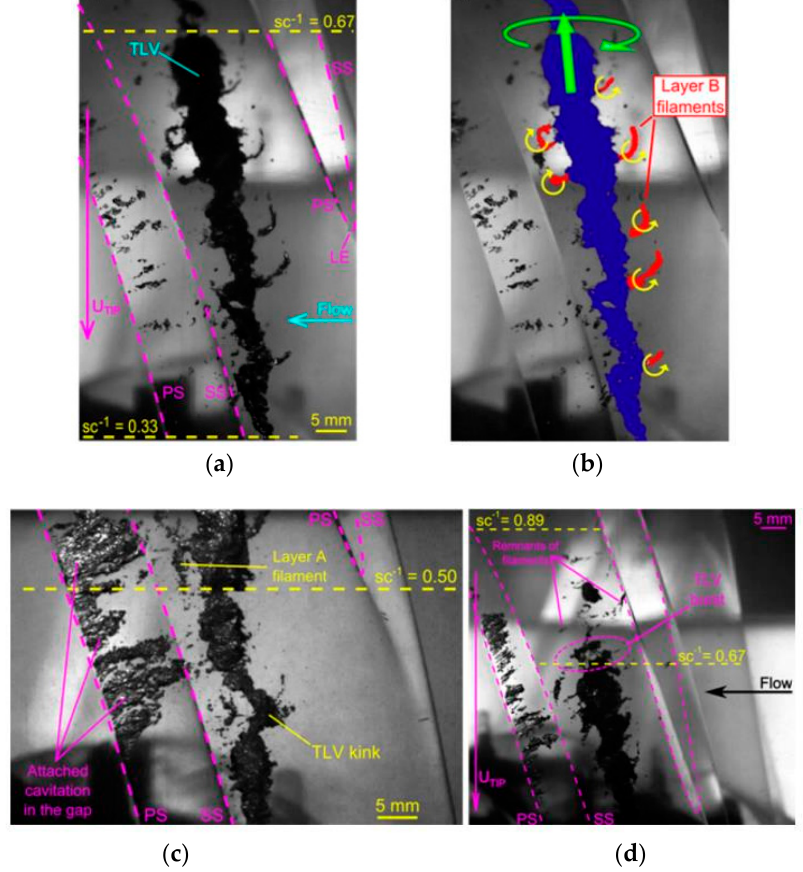
Figure 10. High-speed video images of the three-dimensional tip-leakage vortex [20]. ( a ) Tip leakage vortex; ( b ) Lay B filaments; ( c ) Lay A filaments; ( d ) Remnant filaments and burst. s is a coordinate aligned with the blade chord; c is the chord length; U tip : tip velocity.